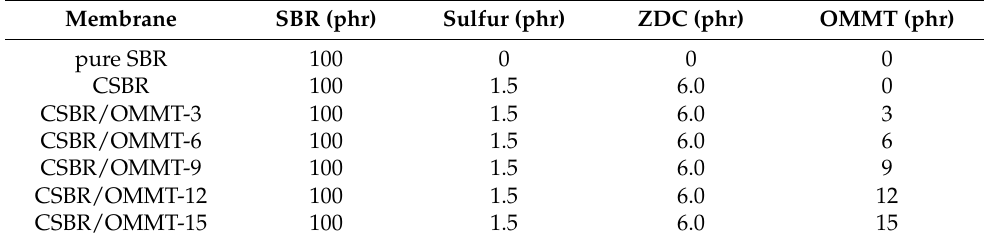
Table 3. Experimental conditions of the preparation of CSBR/OMMT